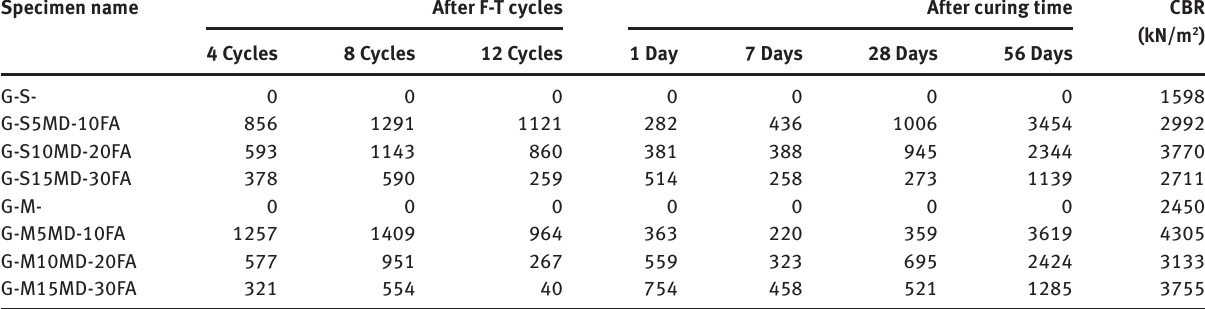
Table 4 Unconfined compressive strength and CBR test results (kN/m 2 ).